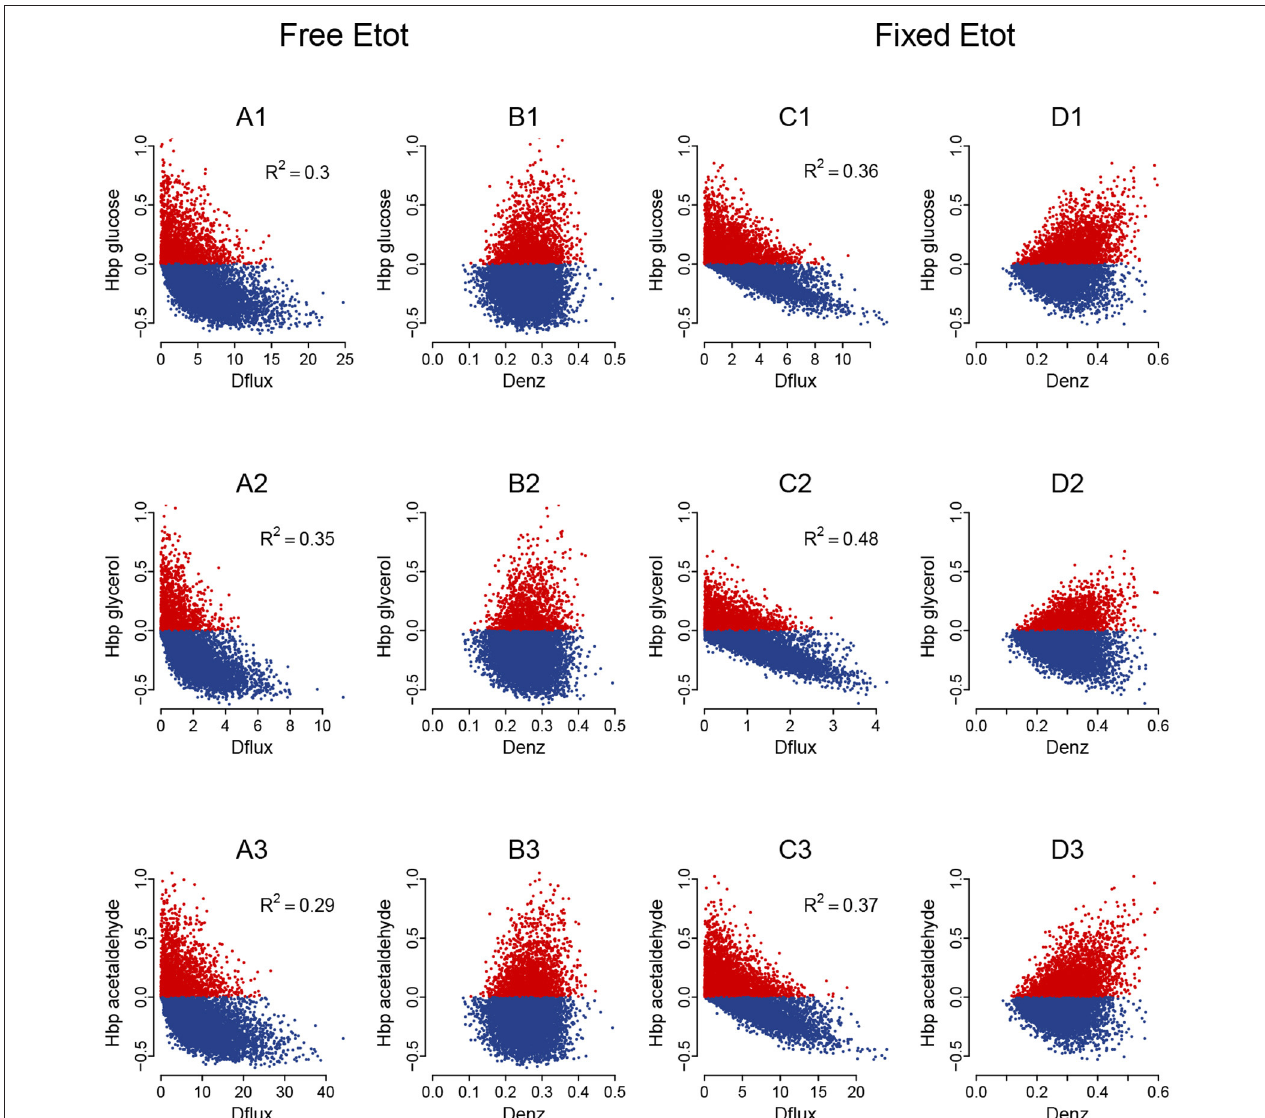
FIGURE 12 | Heterosis predictors in the glycolysis/fermentation network: scatter plots. Relationships between H BP and D flux (A,C) and between H BP and D enz (B,D) with free E tot (A,B) and fixed E tot (C,D) for the glucose flux (A1–D1) , glycerol flux (A2–D2) and acetaldehyde flux (A3—D3) ( c v